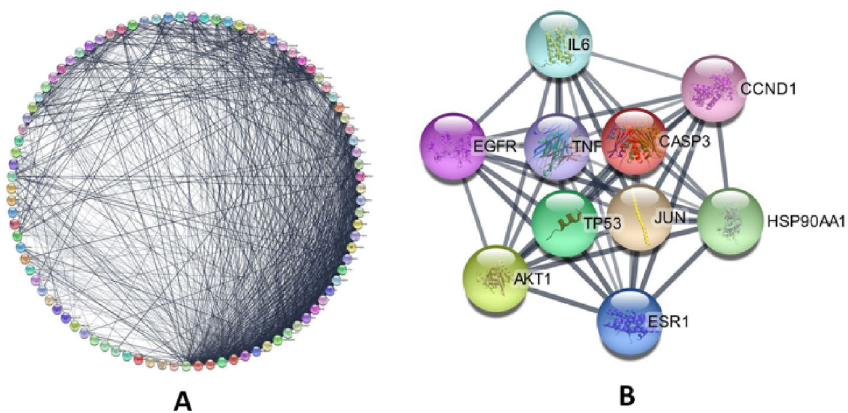
Figure 2. PPI network showing the distribution of nodes and edges ( A, B) which attributes the presence of hub gene Network (https:// string- db. org/).